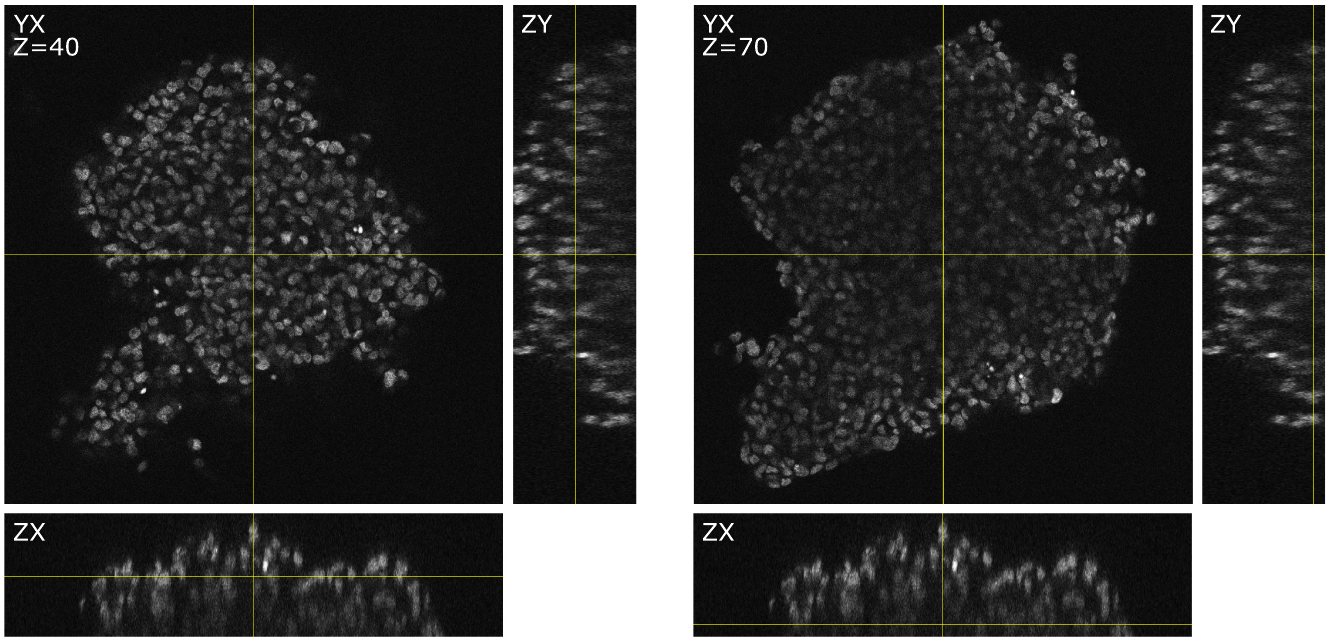
Fig 1. Orthogonal image slices of a 3D cell culture recording. The images are grouped in two triple-sets, each displaying xy , zy and zx views of the same data set. The left side shows a slice at the z -depth 40, and the right side shows a slice at the z -depth 70. The images show a varying quality dependent on the region and a reduced sharpness in the z -axis as a result of the PSF being more spread out in this